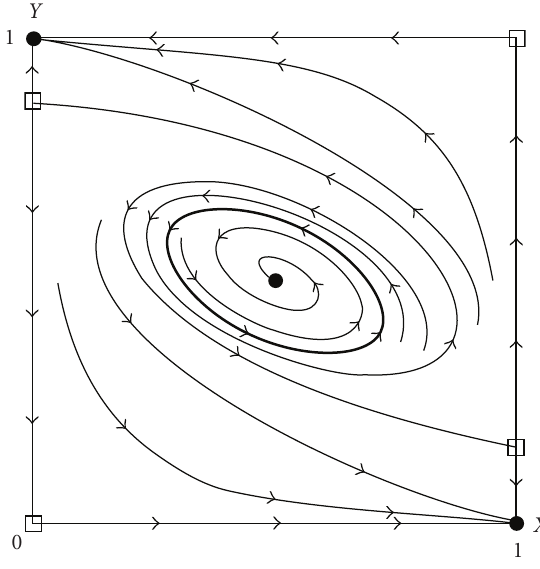
Figure 4.1 . One interior attractor surrounded by a repelling limit